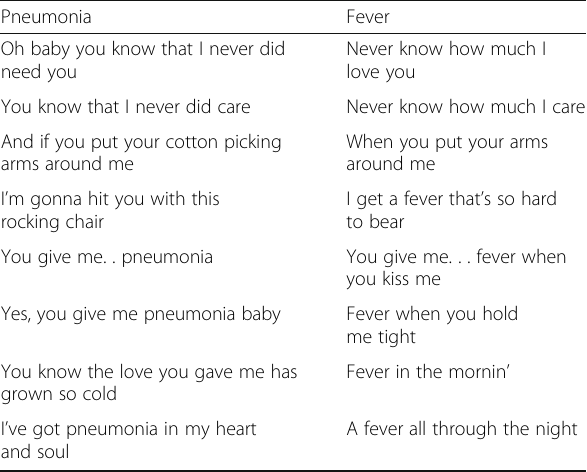
Table 1 Comparison of the lyrics of Pneumonia (Joe Tex) with Fever (Peggy